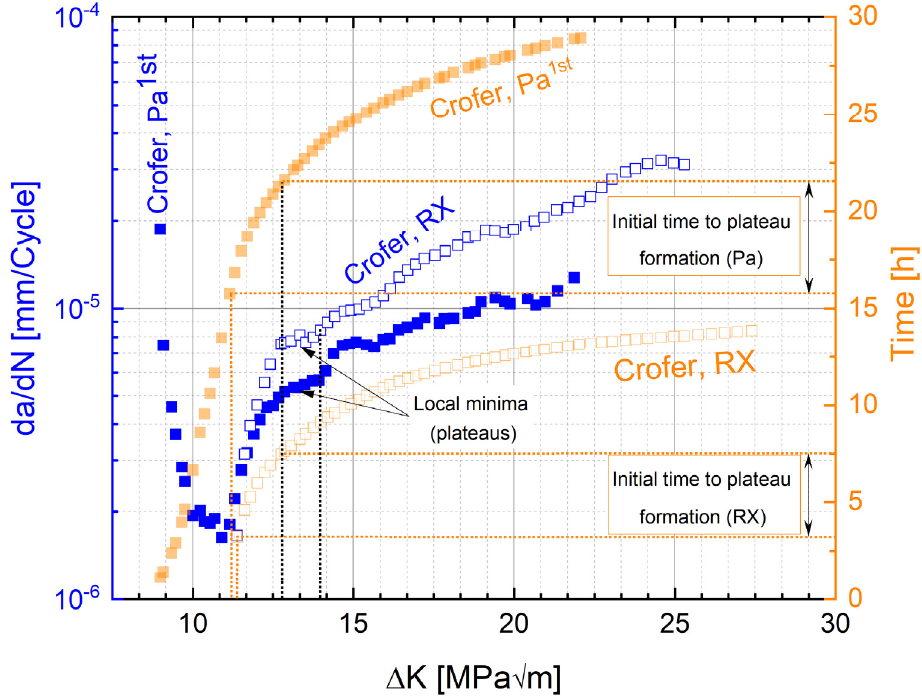
Figure 8. Formation of local minima (plateaus) in Crofer ® 22H in da/dN vs. Δ K/ Δ K vs. time plot (PA curve: time base corrected by heat treatment duration (+1 h)).